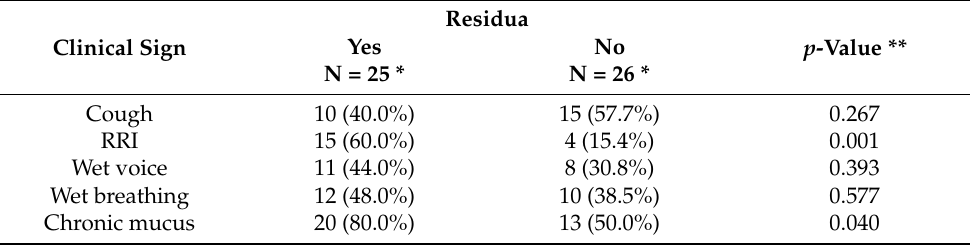
Table 2. Relationships between clinical signs and occurrence of residua in videofluoroscopic swal- lowing study.